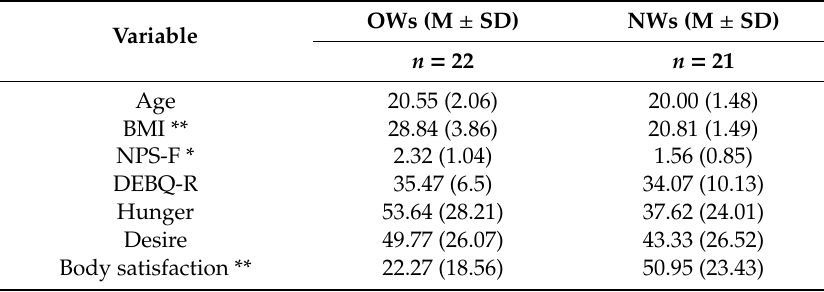
Table 1. Demographic information and self-report results.